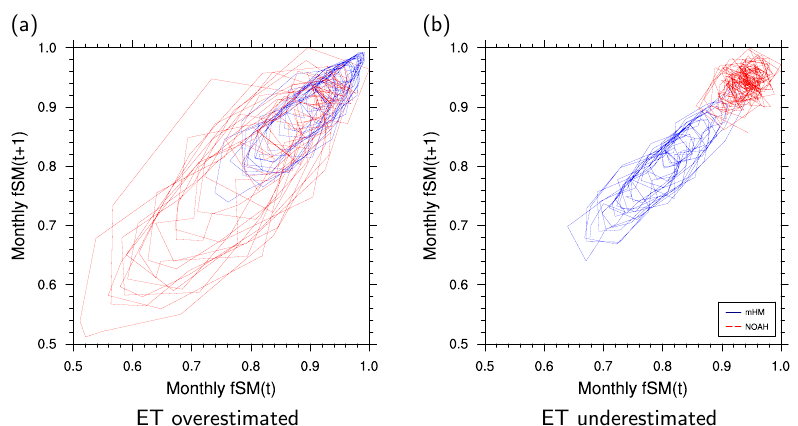
Figure 6. Phase diagrams of monthly soil moisture fraction for two locations in Germany, (a) 54 ◦ N, 10 ◦ E and (b) 51 ◦ N, 7 ◦ E, in which the latent heat estimated by Noah-MP is over- or underestimated with respect to corresponding estimates of mHM. The models have identical